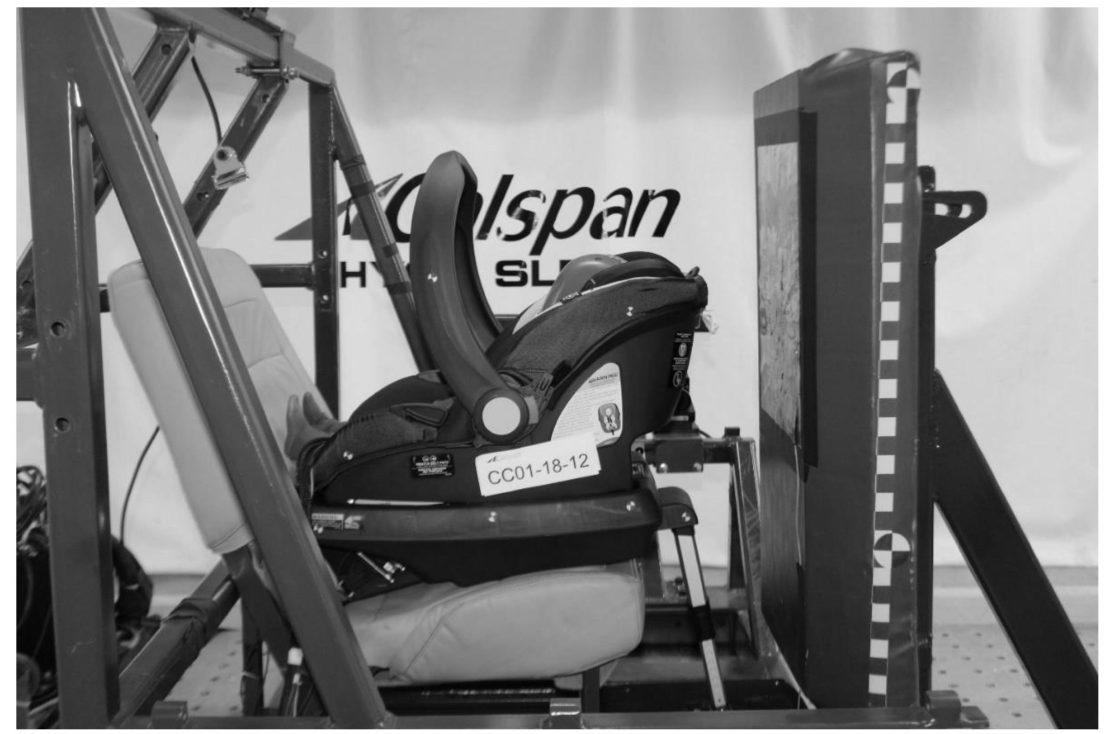
Figure 1. Child ATD seated in rearward-facing infant CRS with support leg installed in the simulated Consumer Reports test buck.